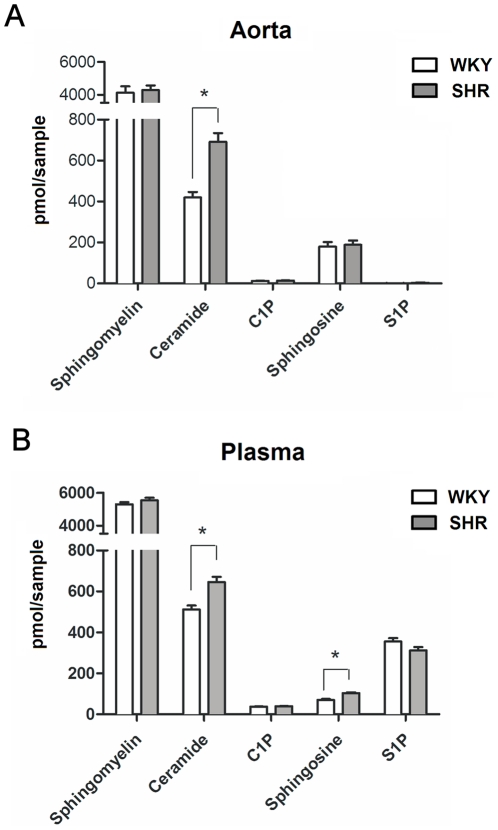
Liquid-chromatography-mass spectrometry measurements of total sphingolipid content.Content was measured in A) SHR and WKY aorta homogenate and B) blood plasma. Data presented as mean ± SEM, n = 3–5 (for 6–10 pooled aortas) and 6–12 (for plasma samples), (*) p<0.05.